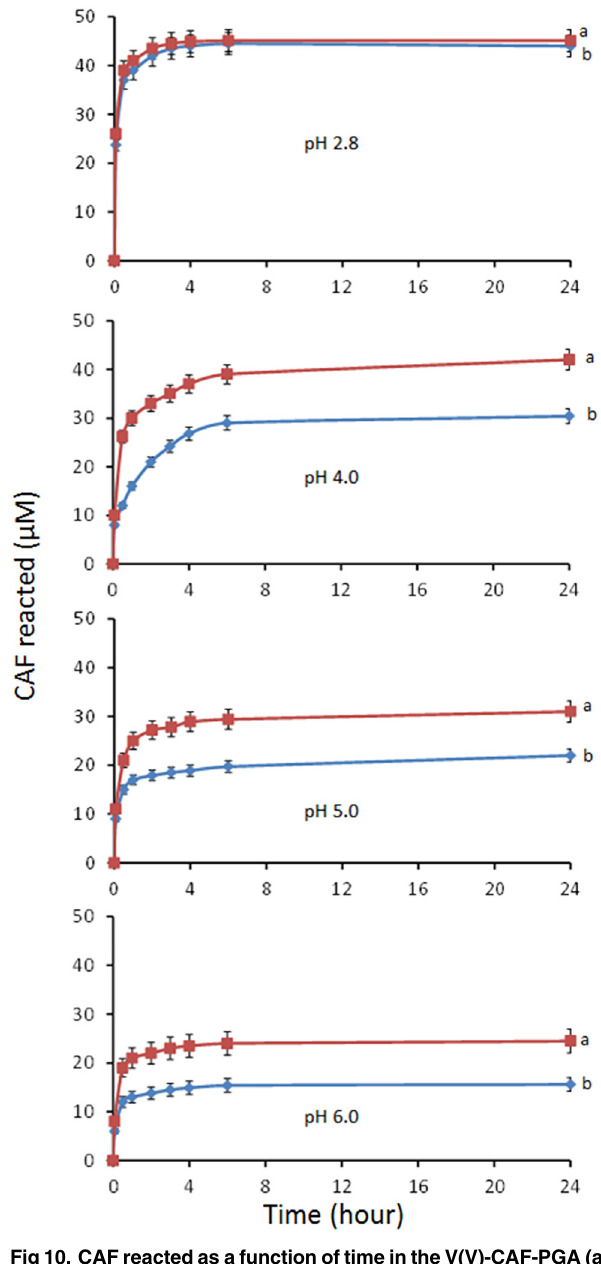
Fig 10. CAF reacted as a function of time in the V(V)-CAF-PGA (a) and V(V)-CAF (b) systems at different pH values. Reaction conditions: CAF 60 μ M; V(V) 120 μ M; PGA 0.25 mg/mL. Mean values ± standard